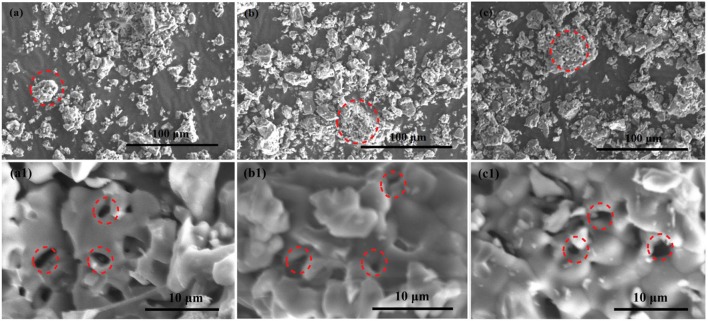
SEM images of Ca12Al14O33
(a,a1), Ca12Al14O33: Tb3+
(b,b1), and Ca12Al14O33: Sm3+
(c,c1) samples.